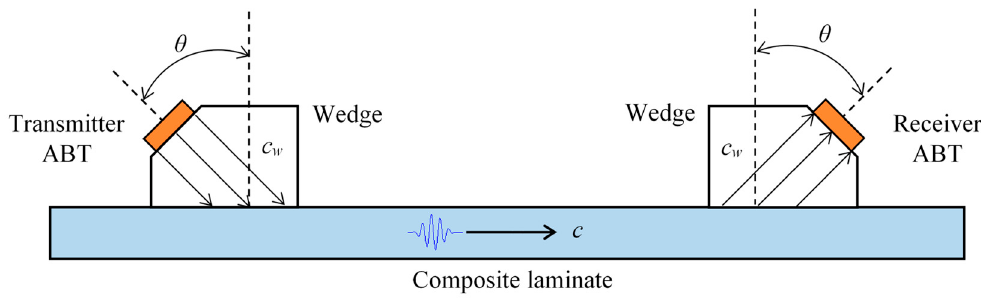
Figure 1. Single-mode wave tuning using an angle beam transducer (ABT) and wedge in a composite laminate. 3. Detection of Various Damage Types Using ABT–ABT on a 2-mm Quasi-Isotropic Composite Plate